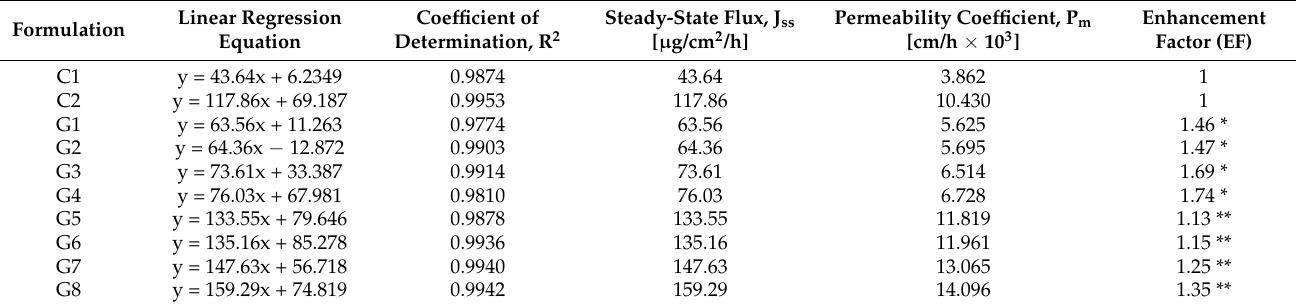
Table 3. Permeability parameters of clindamycin in hydrogel